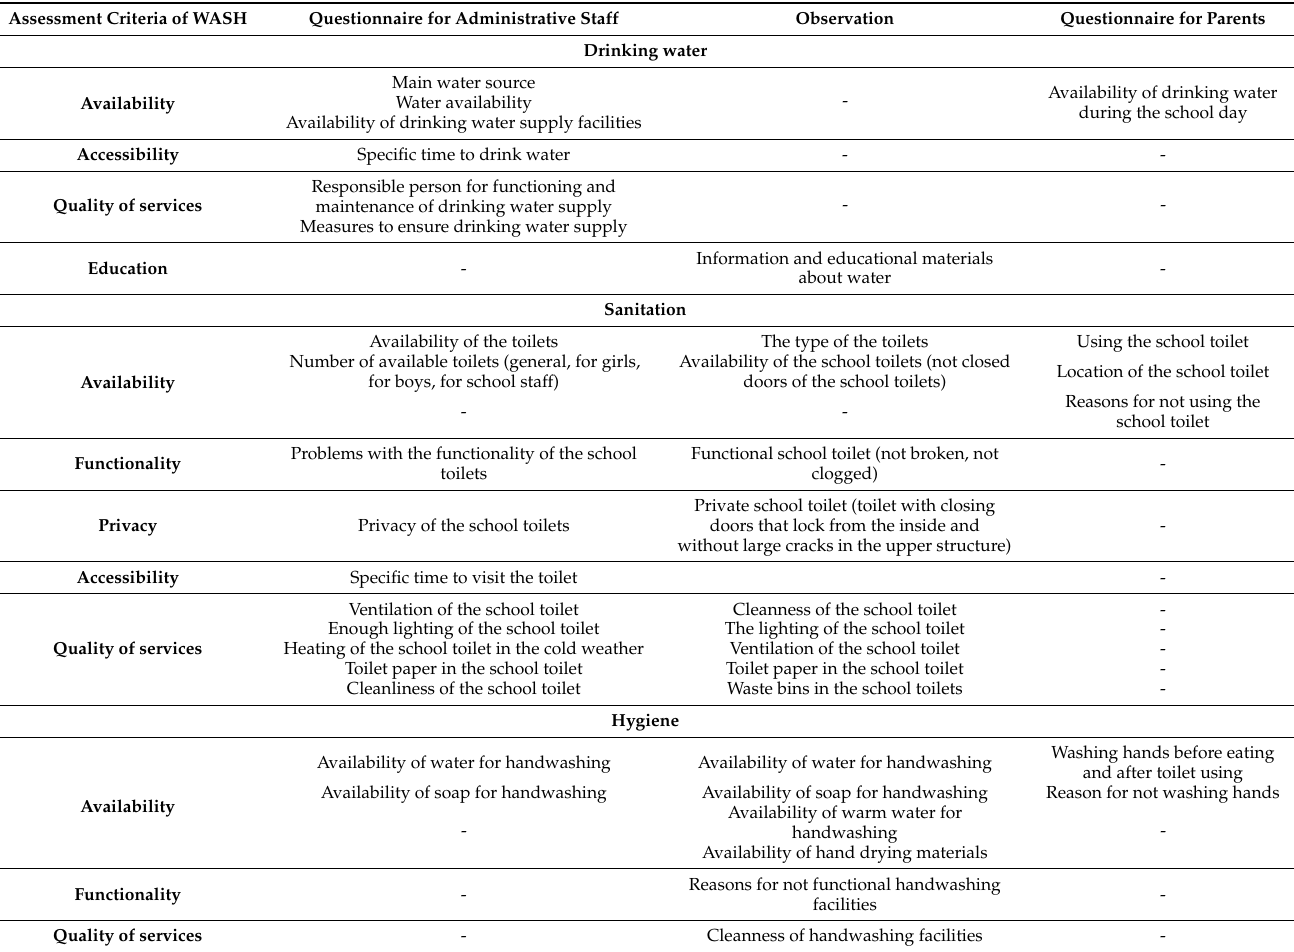
Table 1. Selected questions from the tool WHO/UNICEF “Surveillance of water, sanitation, and hygiene in